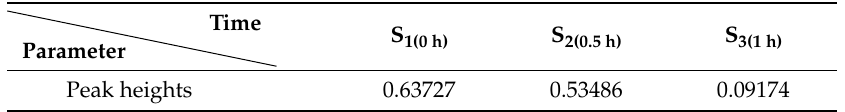
Table 2. Absorption peak heights of -NH-NH 2 in adipicdihydrazide (ADH) after different absorption times.